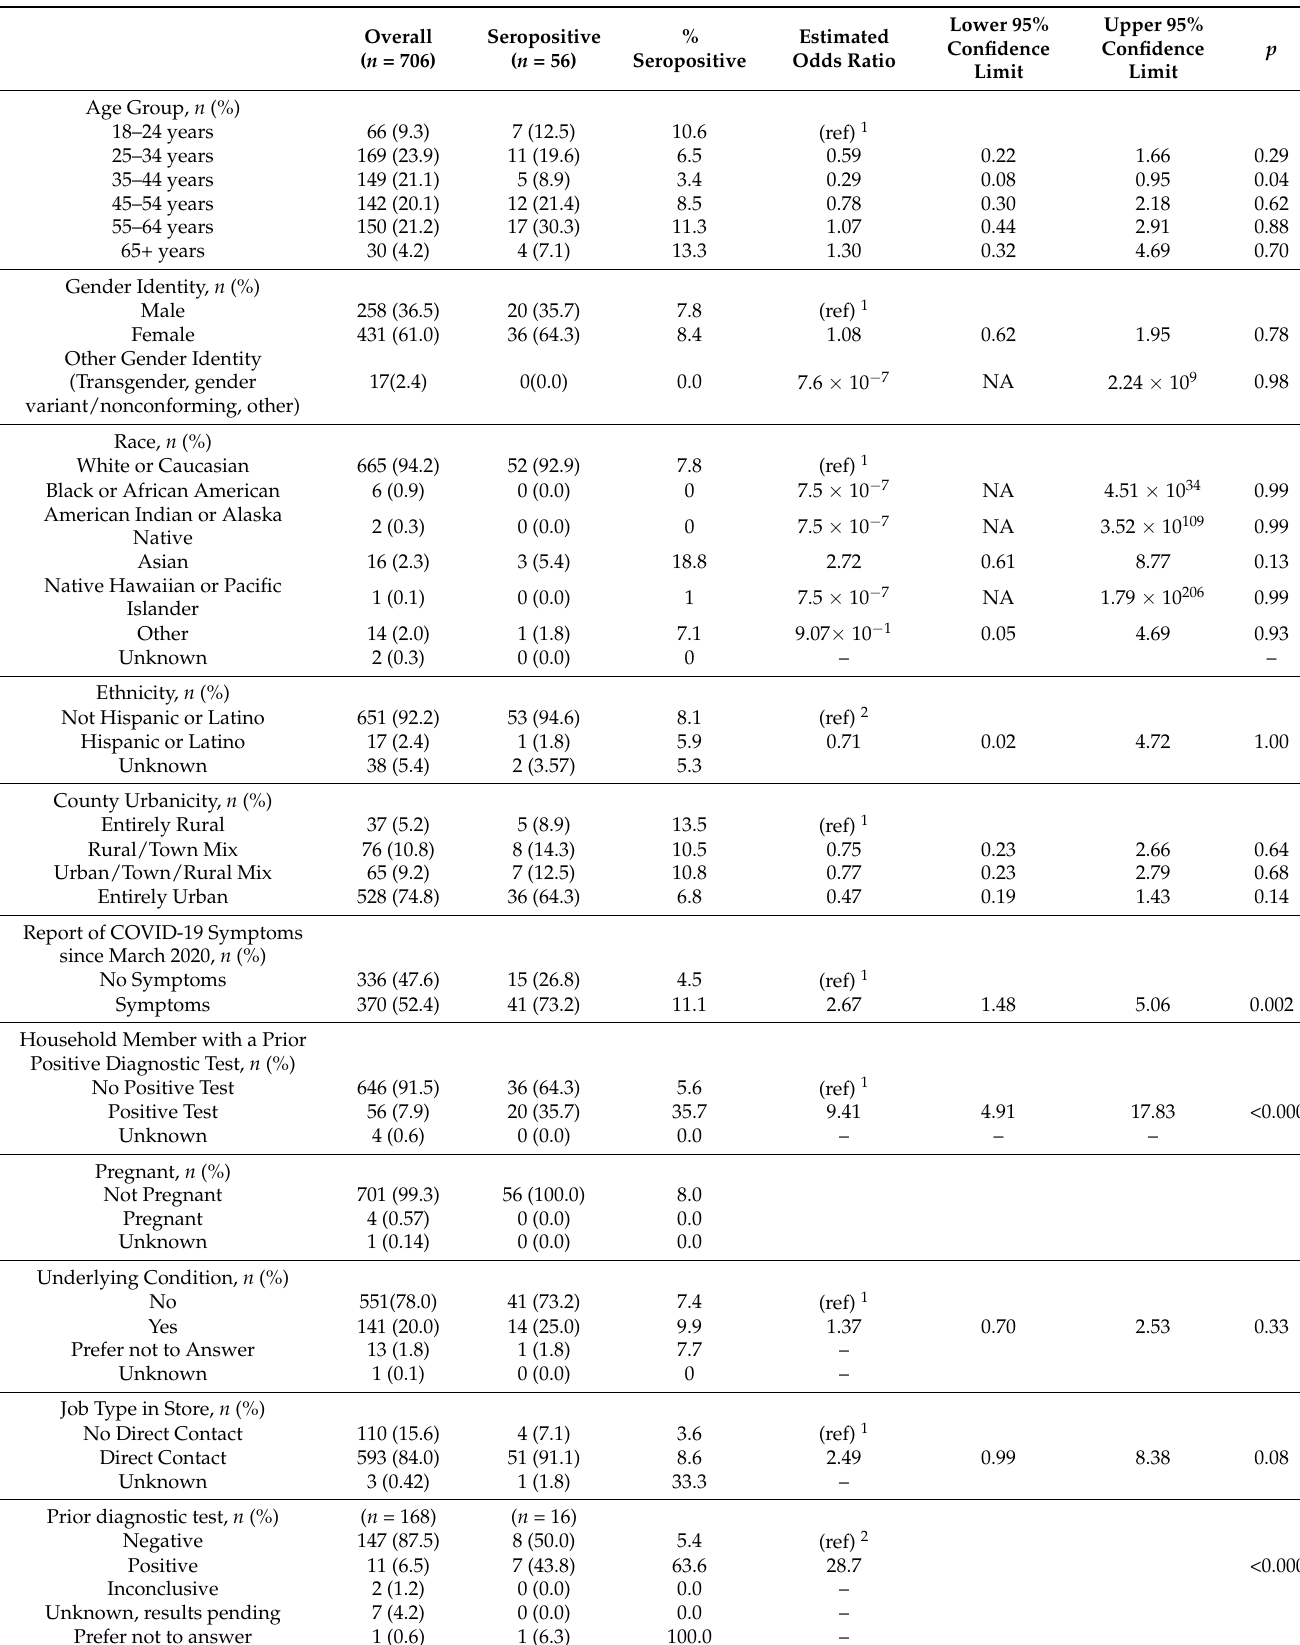
Table 1. Demographic characteristics of study participants by SARS-CoV-2